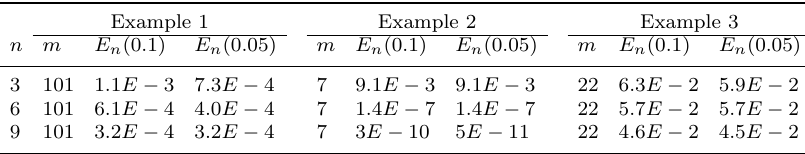
Table 2. Numerical results for Examples 1–3 with noise level 1%.